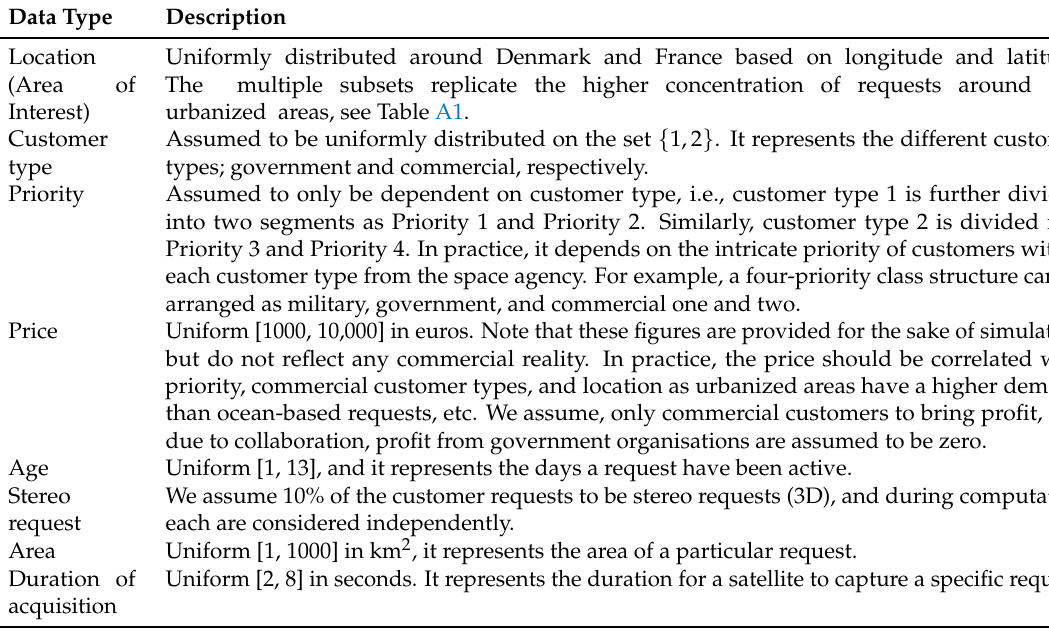
Table 1. Structure of generated